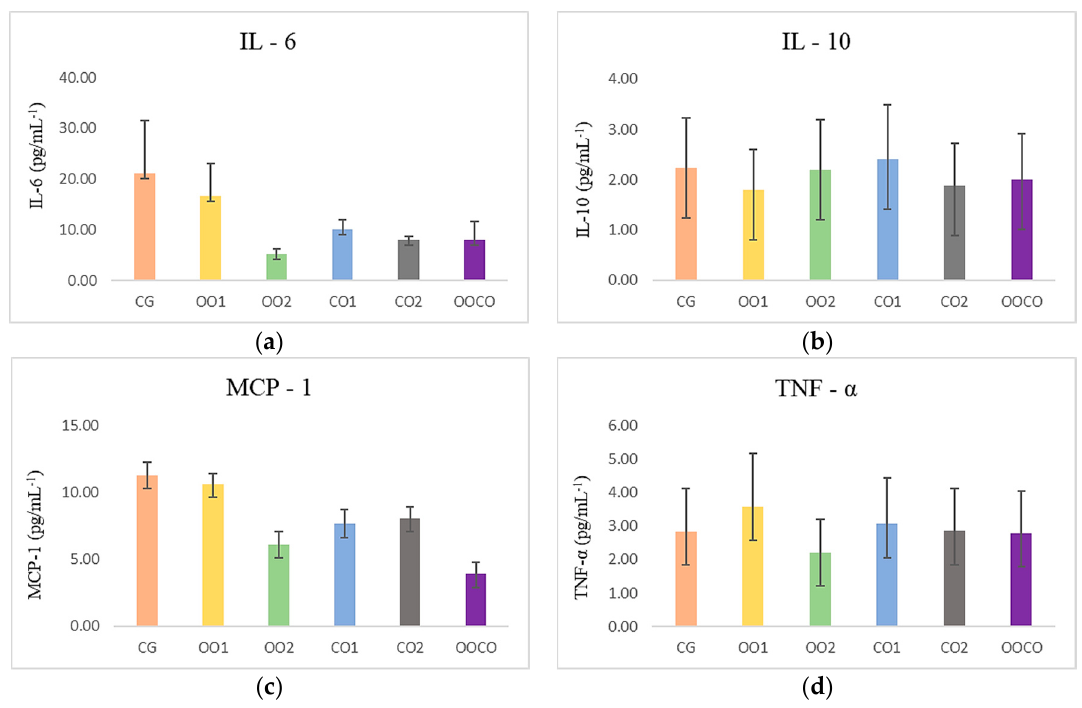
Figure 5. Effects of supplementation from different lipid source on anti- and proinflammatory cytokines. ( a ) Interleukin-6; ( b ) Interleukin-10; ( c ) Monocyte-1 chemotactic protein; ( d ) Tumor necrosis factor alpha. CG indicates control group, supplemented with soybean oil (1000 mg/kg); OO1 and OO2 groups receiving olive oil (1000 mg/kg and 2000 mg/kg, respectively); CO1 and CO2 groups supplemented with Caryocar brasiliense oil (1000 mg/kg and 2000 mg/kg, respectively); and OO + CO group receiving olive oil (1000 mg/kg) with C. brasiliense oil (1000 mg/kg). ANOVA: one-way analysis of variance.